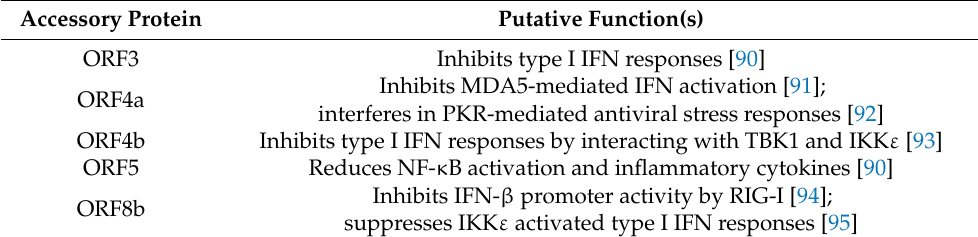
Table 2. Putative functions of MERS-CoV accessory proteins.